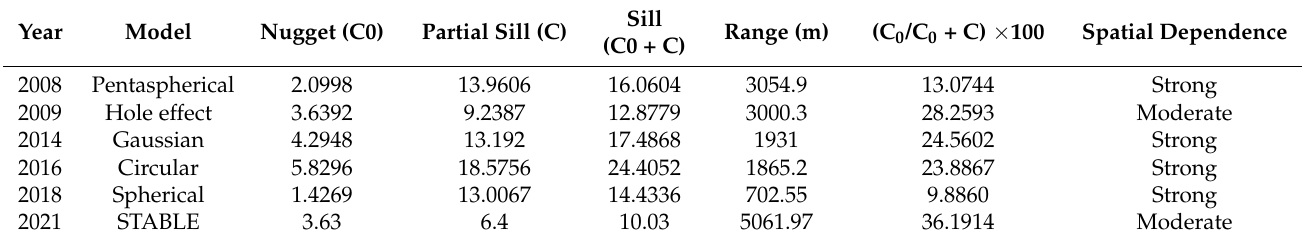
Table 4. Fitted experimental semivariograms parameters and their cross-validation results.